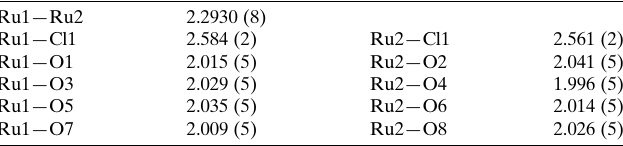
Table 1 Selected bond lengths (A˚ ).